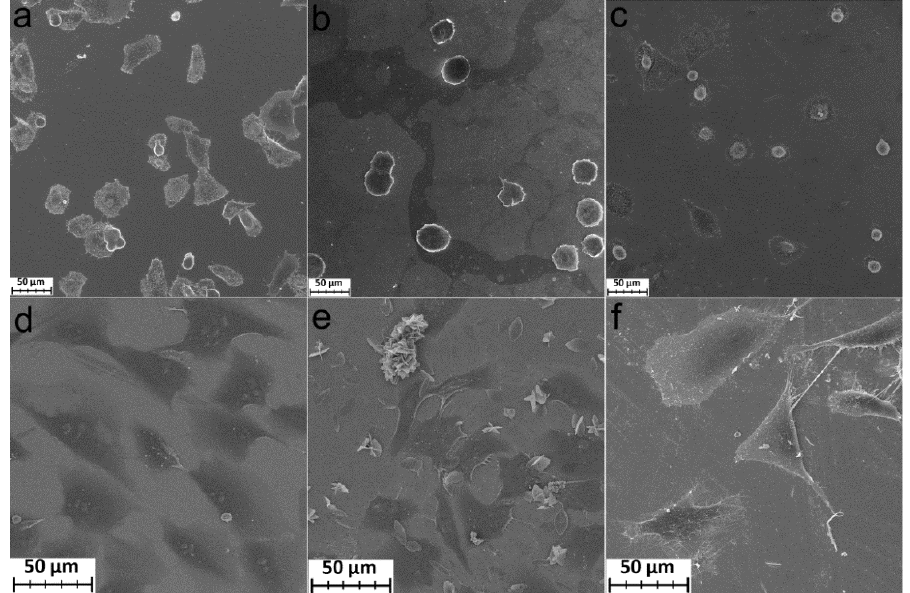
Figure 8. SEM images of MG-63 cells incubated during 2 h ( a – c ) and 24 h ( d – f ) on Ti ( a , d ), Ti-TiO 2 (TiCl 4 /H 2 O) ( b , e ), and Ti-TiO 2 (TTIP/H 2 O) ( c , f ) samples.